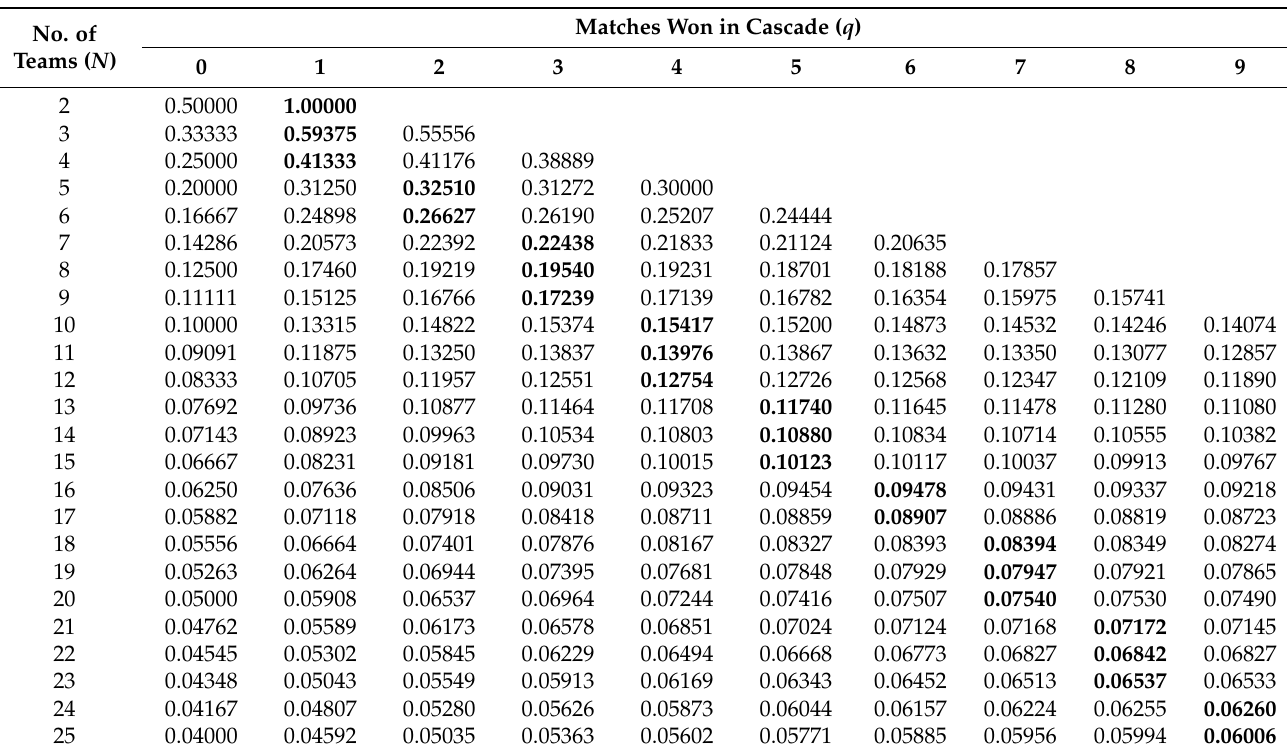
N teams and scoring pattern {3, 1, 0}, we can standardize and, therefore, compare, using 0}. (Maximum of HHI in